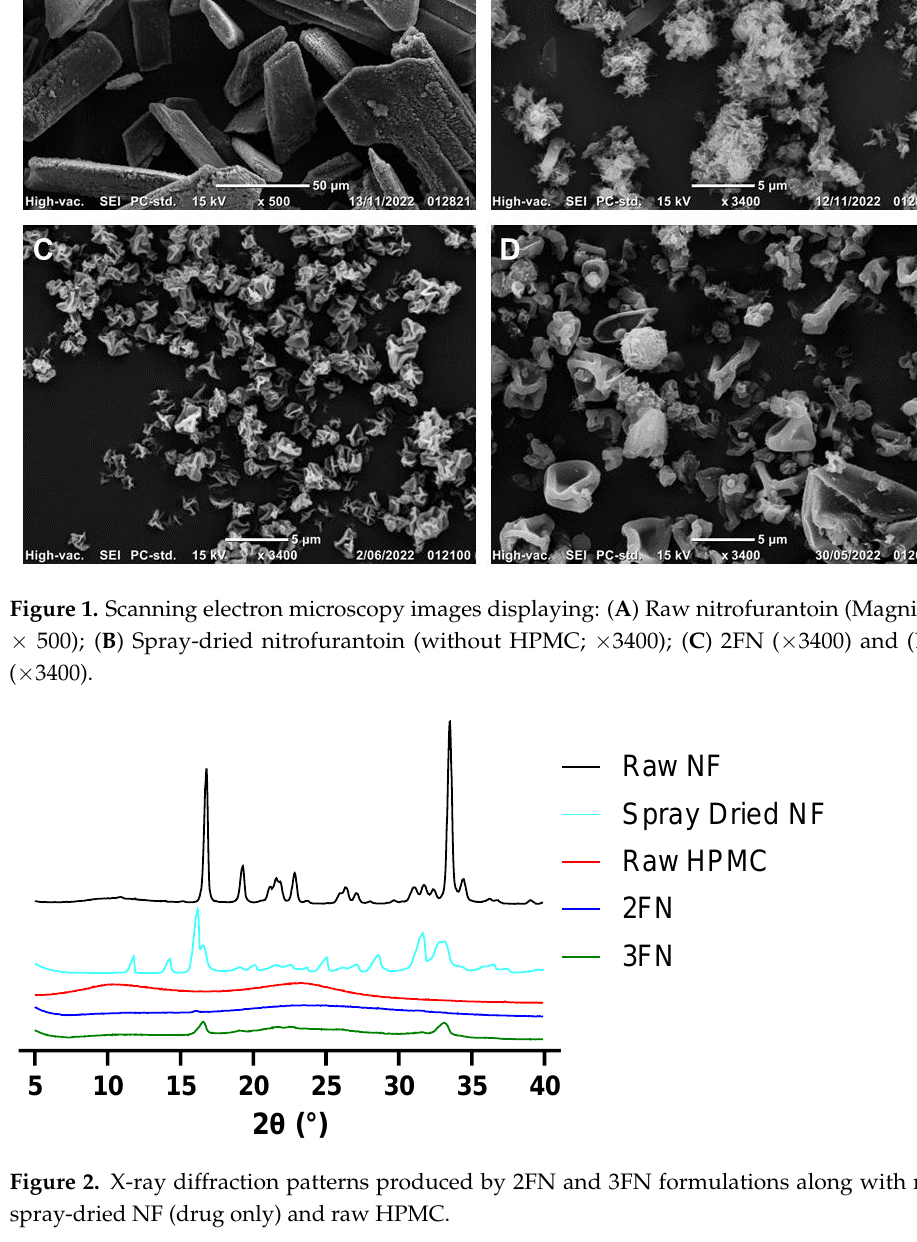
Figure 2. X-ray diffraction patterns produced by 2FN and 3FN formulations along with raw NF, spray-dried NF (drug only) and raw HPMC.